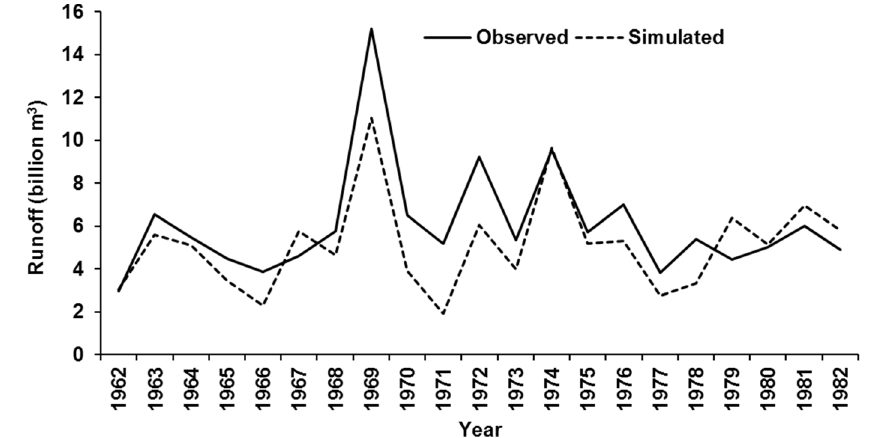
Figure 2. Simulated runoff data against the observed runoff